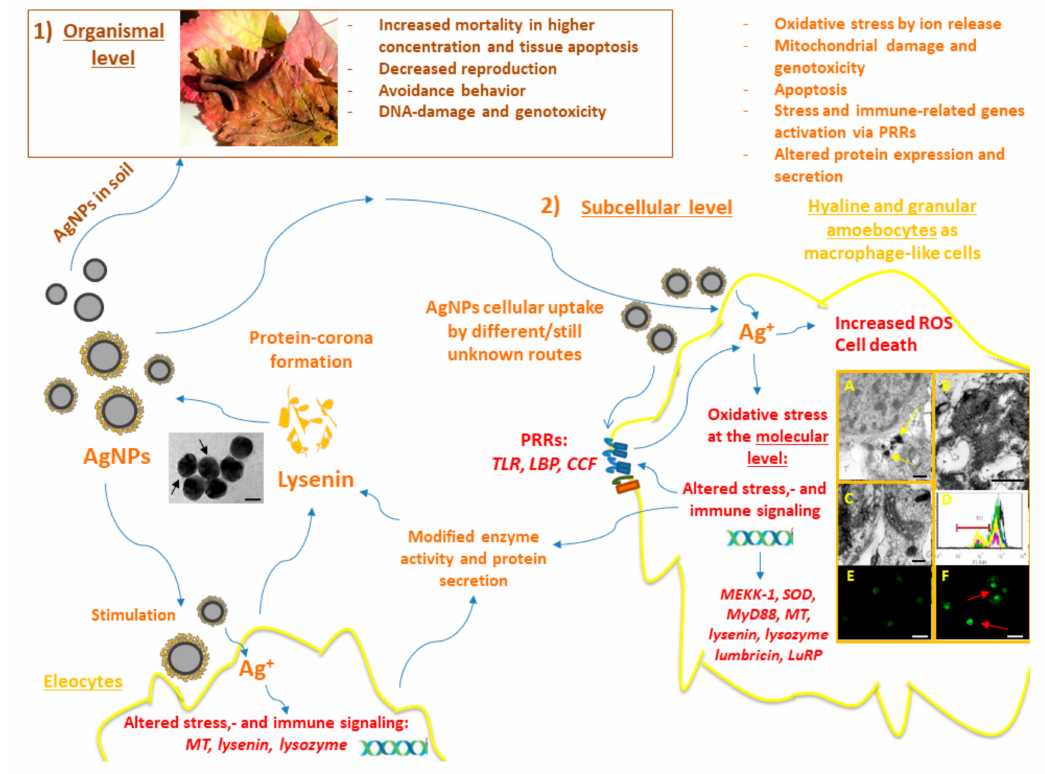
Figure 1. Schematic overview of the AgNPs’ impacts on earthworms at di ff erent biological levels. ( 1 ) AgNP toxicity at the organismal level: The representative image depicts an E. fetida earthworm. Adjacent to the image, the deleterious e ff ects of AgNPs known from the in vivo earthworm experimental literature are listed. ( 2 ) AgNP toxicity at the sub-cellular level: Di ff erent endpoints of AgNP toxicity are detailed in the upper right corner. Blue arrows demonstrate the directionality and impacts of AgNPs. AgNPs can interact with both amoebocytes and eleocytes. Recognition of AgNPs in target amoebocytes is achieved probably by an assortment of PRRs, and various endocytosis pathways are engaged (please see the main text and Figure 2). Our studies revealed that lysenins are the key constituents of AgNP-protein corona from earthworm coelomocytes. The representative TEM image shows the coelomic fluid-derived protein coating of AgNPs (black arrows, scale bar: 50 nm). AgNPs caused irreversible alterations in amoebocytes, in vitro; in the cytoplasm, AgNP aggregates ( A ) (yellow arrows) can be observed by TEM (scale bar: 200 nm). Apoptotic nucleus ( B ) and atypical mitochondria ( C ) can be seen in amoebocytes exposed to AgNPs revealed by TEM (scale bars: 500 nm, 200 nm). Mitochondrial membrane potential was significantly decreased ( D ), as indicated by MitoView fluorescent dye-based flow cytometry (representative histogram) (black line—control, red line—15 µ g / mL AgNP, blue line—30 µ g / mL AgNP, purple line—40 µ g / mL µ g / mL AgNP, green line—20 µ g / mL AuNP, yellow line—1.35 µ g / mL AgNO 3 ). TUNEL assay demonstrated TUNEL − ( E ) and TUNEL + ( F ) apoptotic nuclei from control or AgNP exposed coelomocytes, respectively (red arrows, scale bars: 20 µ m). In Vitro, the lower-cytotoxic concentrations of AgNPs at the molecular level can manifest in biased gene expression of stress-related factors and immunologically-active secretory proteins (such as lysenins). These gene expression profiles signify the involvement of antioxidant systems such as SOD , and persistent up-regulation of MT in Eisenia underlining the thiol-mediated detoxification process. The prompt regulation of TLR to AgNPs was apparent in E. fetida coelomocytes as an NP-specific